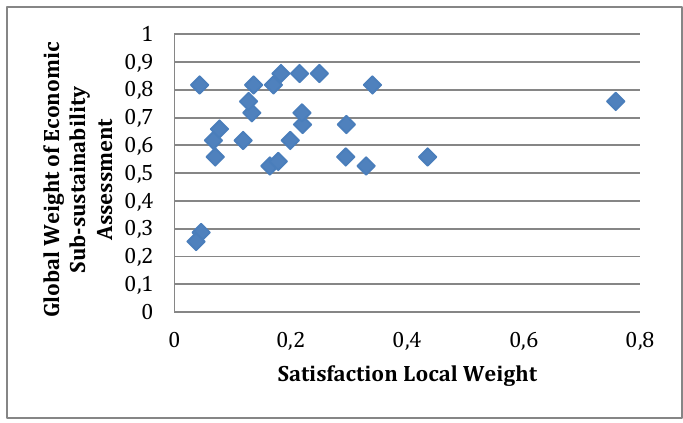
Figure 26: Global weight vs. satisfaction local weight of economic sub-sustainability assessment, micro-scale literature based assessment